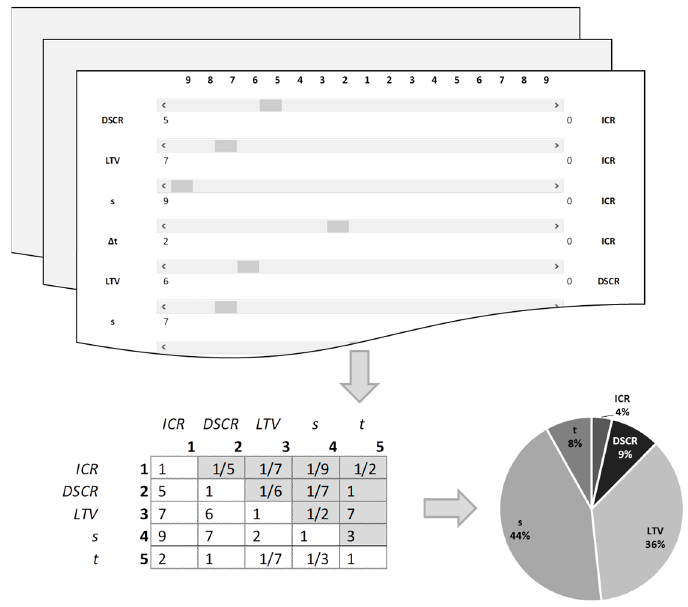
Figure 1. Graphical representation of the AHP application.